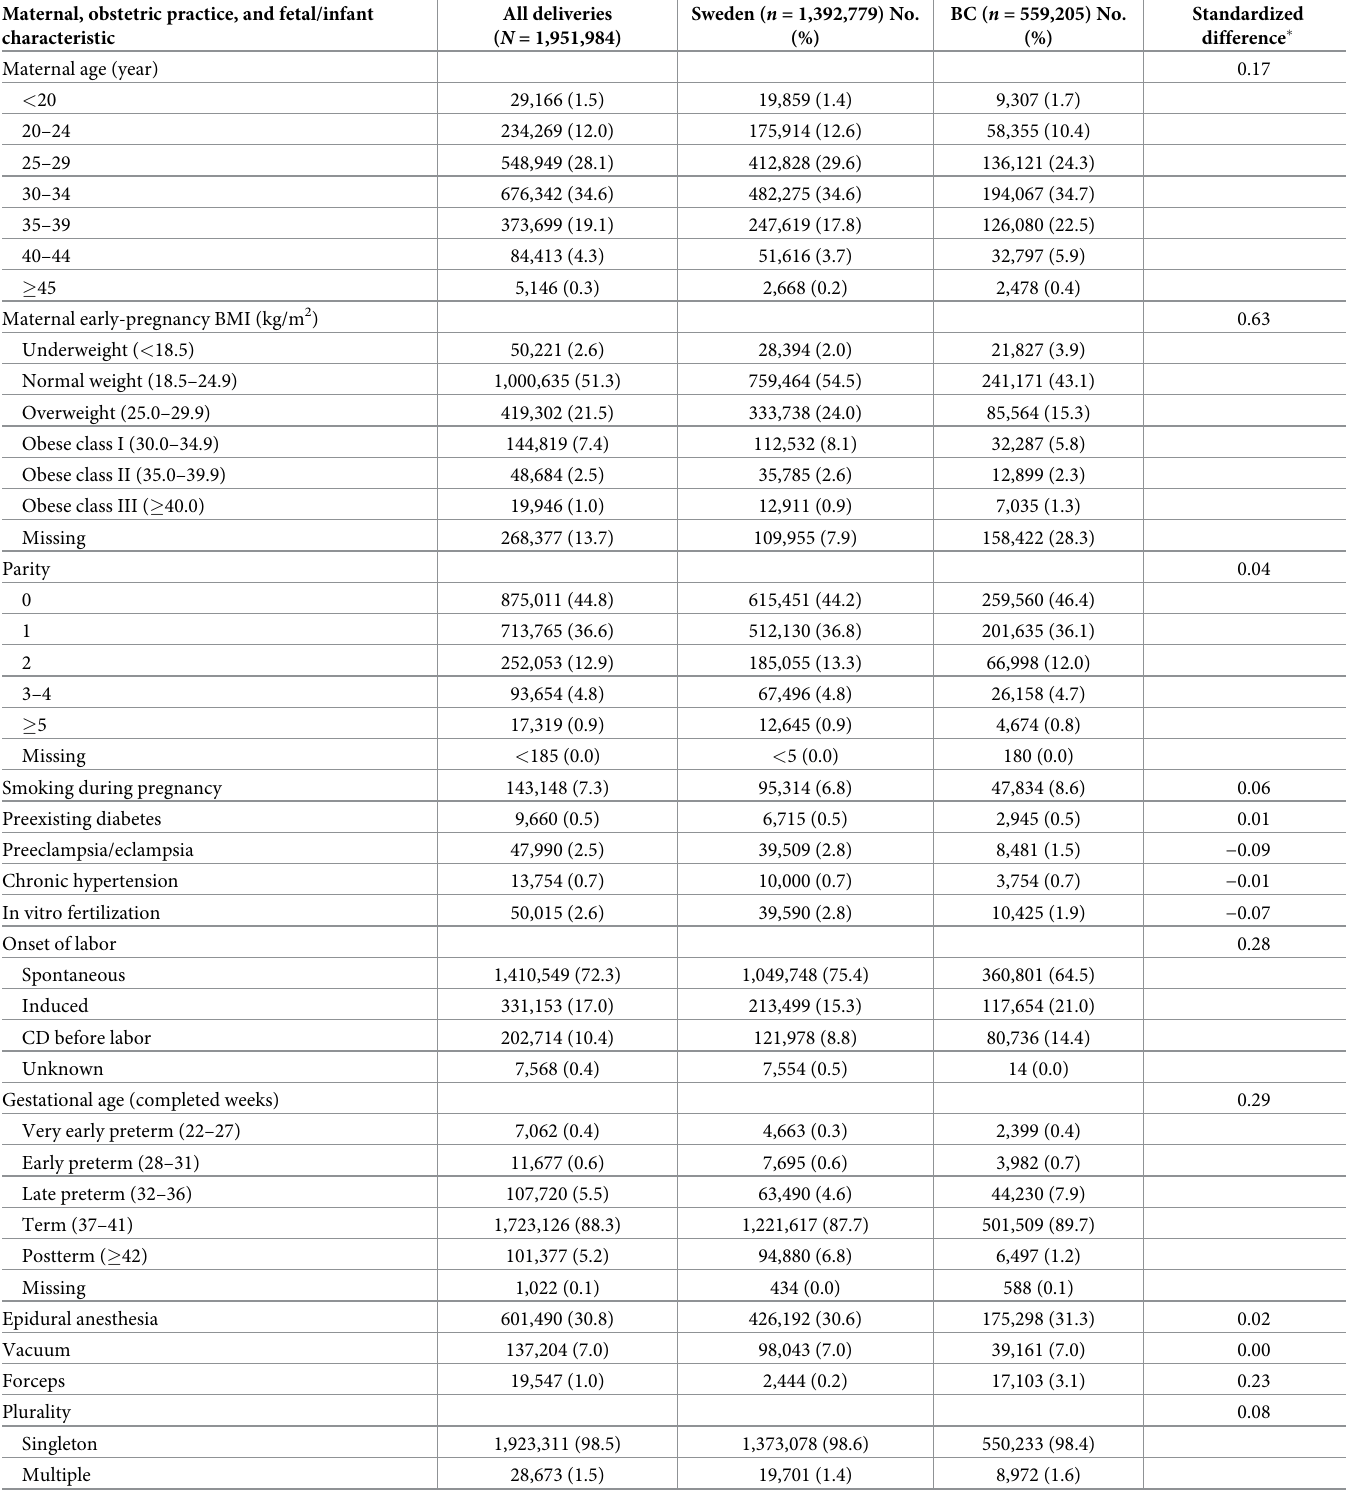
Table 1. Distribution of maternal, obstetric practice, and fetal/infant characteristics among deliveries in Sweden and BC, Canada, 2004–2016. Maternal, obstetric practice, and fetal/infant